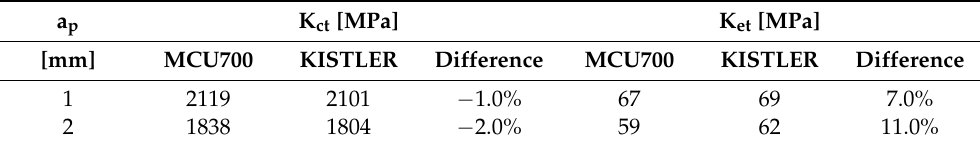
Figure 11. Dependence of the tangential cutting force component on the feed per tooth: ( a ) for axial depth of cut 1 mm; ( b ) for axial depth of cut 2 mm. Table 6. Resulting coefficients, K ct and K et . The KISTLER dynamometer data were used as a